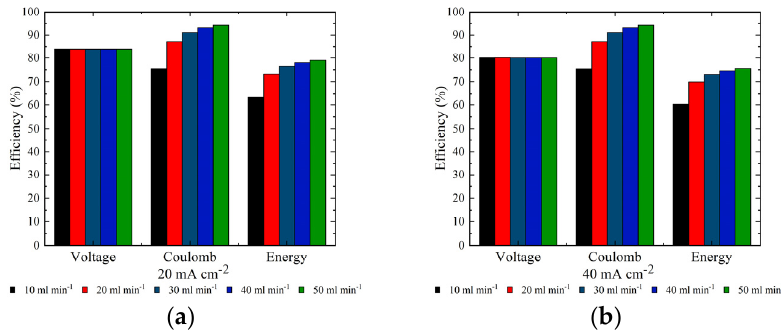
Figure 7. Voltage, coulomb, and energy efficiency of battery with different positive electrolyte flow rates at current densities of ( a ) 20 mA cm − 2 and ( b ) 40 mA cm − 2 .